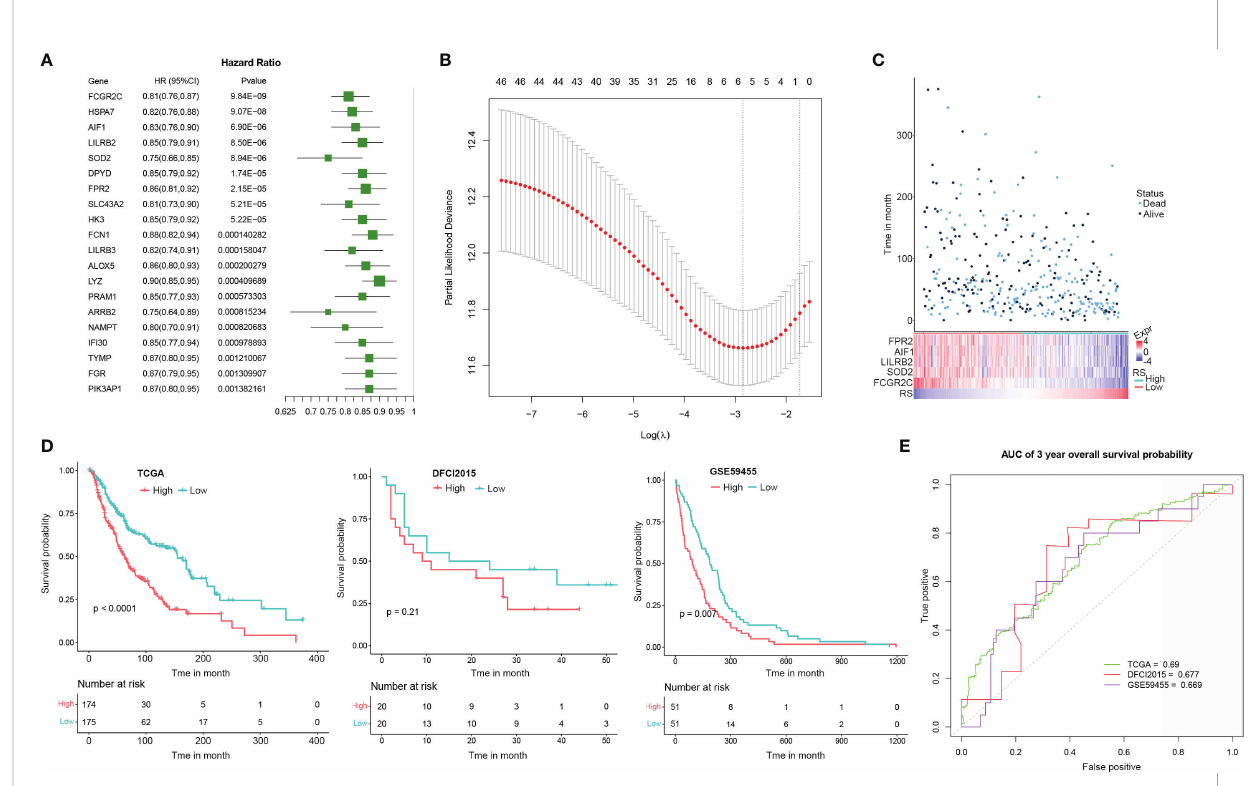
FIGURE 4 The signature based on the CEBPB-regulated genes in macrophages could robustly distinguish prognostically different metastatic SKCM patients. (A) Forest plot illustrating the hazard ratio (HR) and signi fi cance of the top 20 most signi fi cant CEBPB-regulated genes in macrophages in univariate Cox regression analysis of their association with overall survival probability of metastatic SKCM patients in TCGA-SKCM cohort. (B) LASSO Cox regression plot showing the optimal number of genes to be included in the death risk score (RS) signature. (C) RS and the overall survival time (month) as well as the survival status of each metastatic SKCM patient in TCGA-SKCM were altogether provided as a dot plot along with a heatmap. Each dot represents a patient, with dot color indicating the survival status, and the corresponding RS could be obtained through the last row of the heatmap. The relative expression of genes included in the signature was also illustrated in the heatmap. (D) KM survival probability curve of metastatic SKCM patients in TCGA-SKCM (left panel), DFCI2015 (middle panel), and GSE59455 (right panel) cohorts. The patients were grouped by the median RS value. p-Value was determined by using log-rank test. (E) Survival ROC curve for estimating the reliability of the RS in predicting the 3-year overall survival probability. The curve color represents the dataset used as indicated in the plot. SKCM, skin cutaneous melanoma; LASSO, least absolute shrinkage and selection operator; KM, Kaplan – Meier; ROC, receiver operating